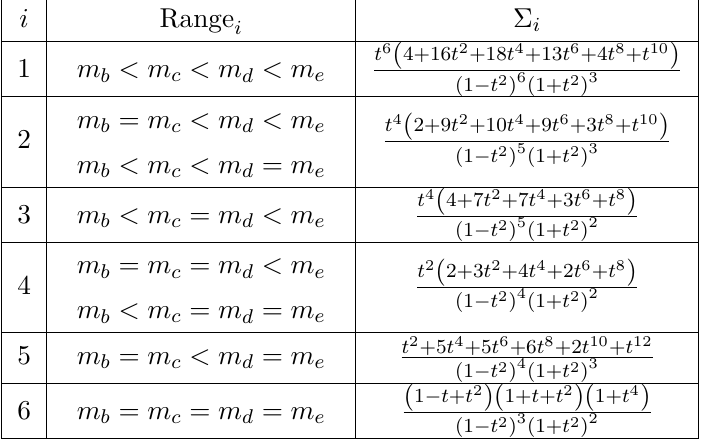
Table 15 . Definitions of the ranges involved in the sums (C.3), and exact values of these sums. When there are two possible ranges, this means that the two choices lead to the same